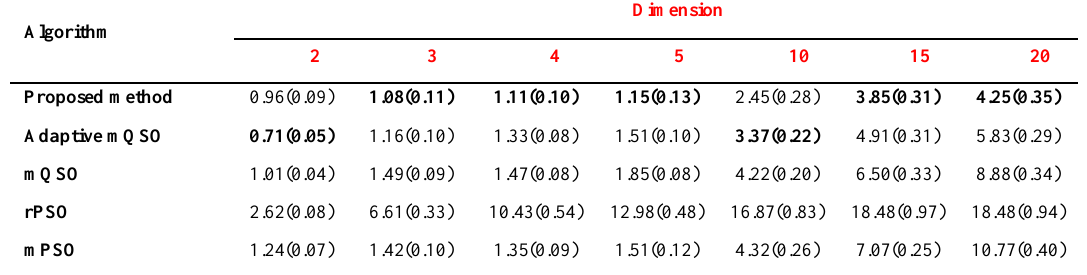
Figure 15. Average offline error for proposed algorithm Figure 14. Comparison between proposed algorithm with with different memory sizes and default values for MPB AmQSO in frequency change = 500, peak number = 10, and problem. different correlation coefficients ( ). Table 6. Result of proposed method with different dimensions involving peak number of 10, frequency change of 5000, and shift length of 1, in comparison with mQSO, AmQSO, rPSO, and mPSO.